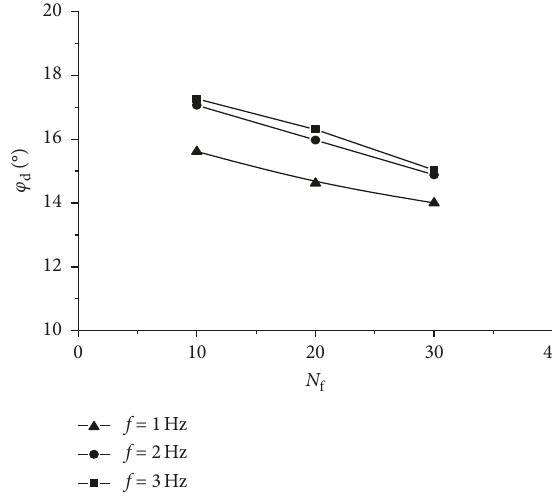
Figure 9: Relationship curves between dynamic internal friction angle and failure cycles at different